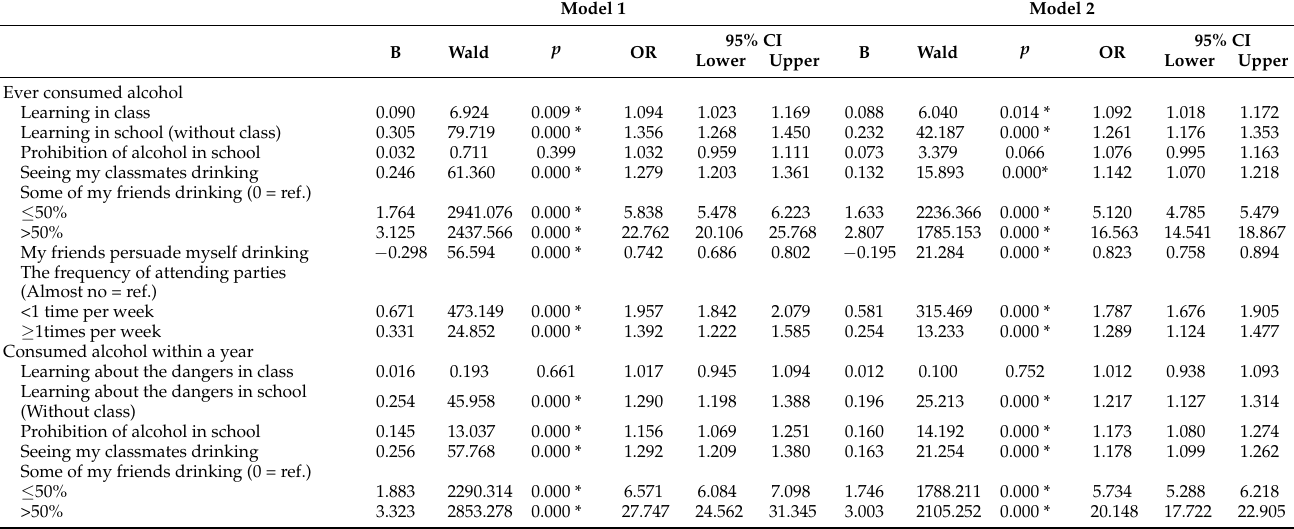
Table 3. Unadjusted and adjusted logistic regression analyses of school environment factors and alcohol